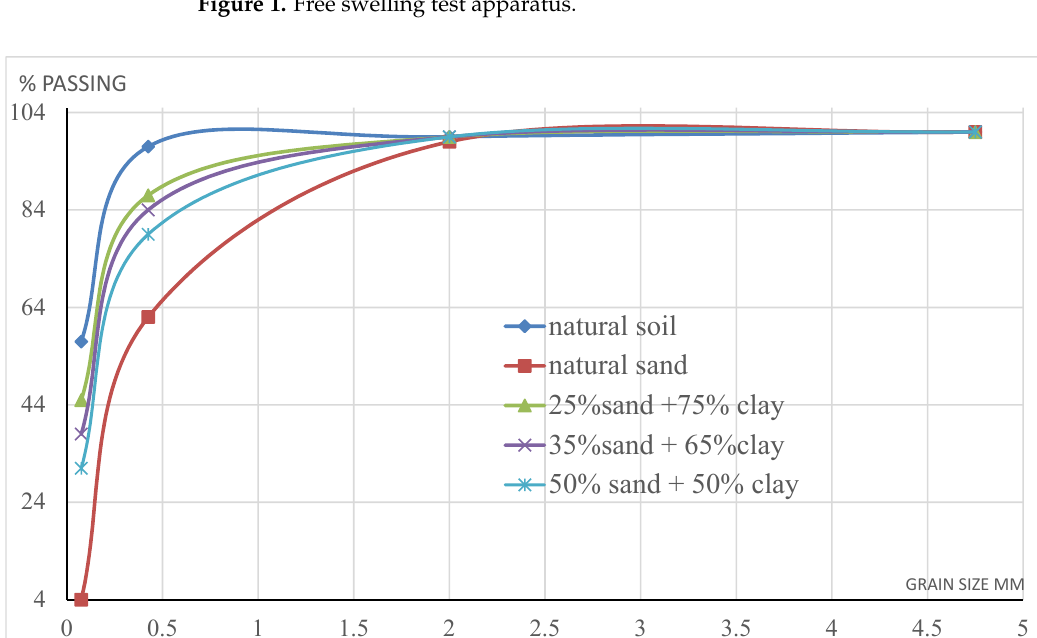
Figure 2. The grading curves of natural soil, natural sand, and the treated soils with different percentages of sand.